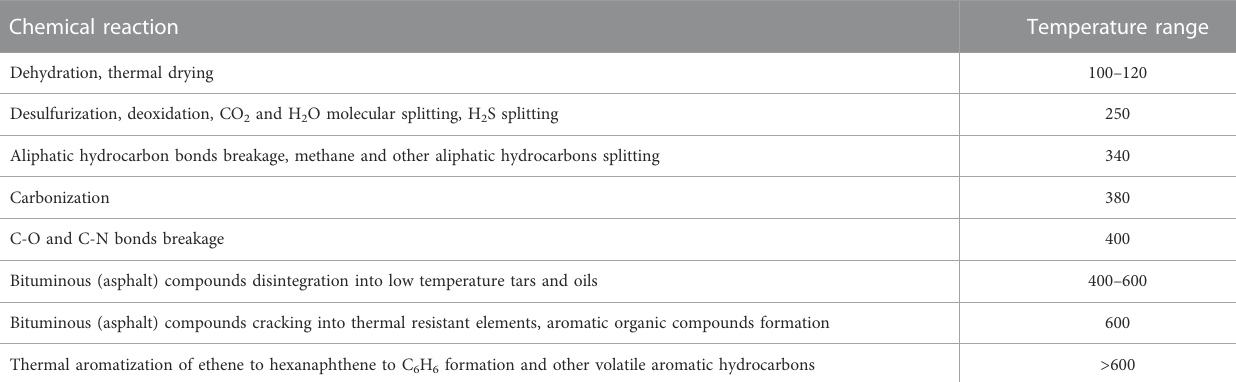
TABLE 4 Temperature-dependent pyrolysis reactions (Bilitewski et al.,